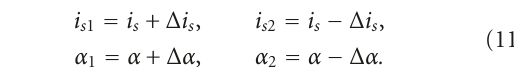
Figure 16: BER of 16-QAM signal for di ff erent levels of diodes mis- matches. From left to right: without mismatch, i s mismatch of 10%, α mismatch of 10%, both α and i s mismatch of 10%.